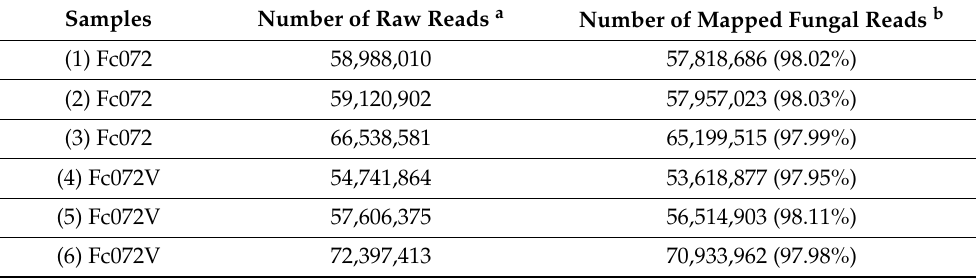
Table 2. Summary of the sequence reads.